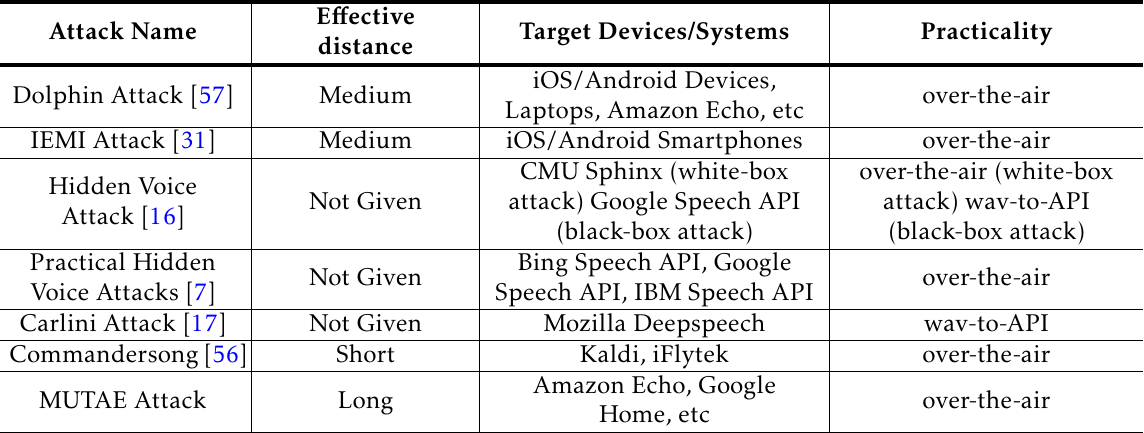
Table 5. Comparison among voice spoofing